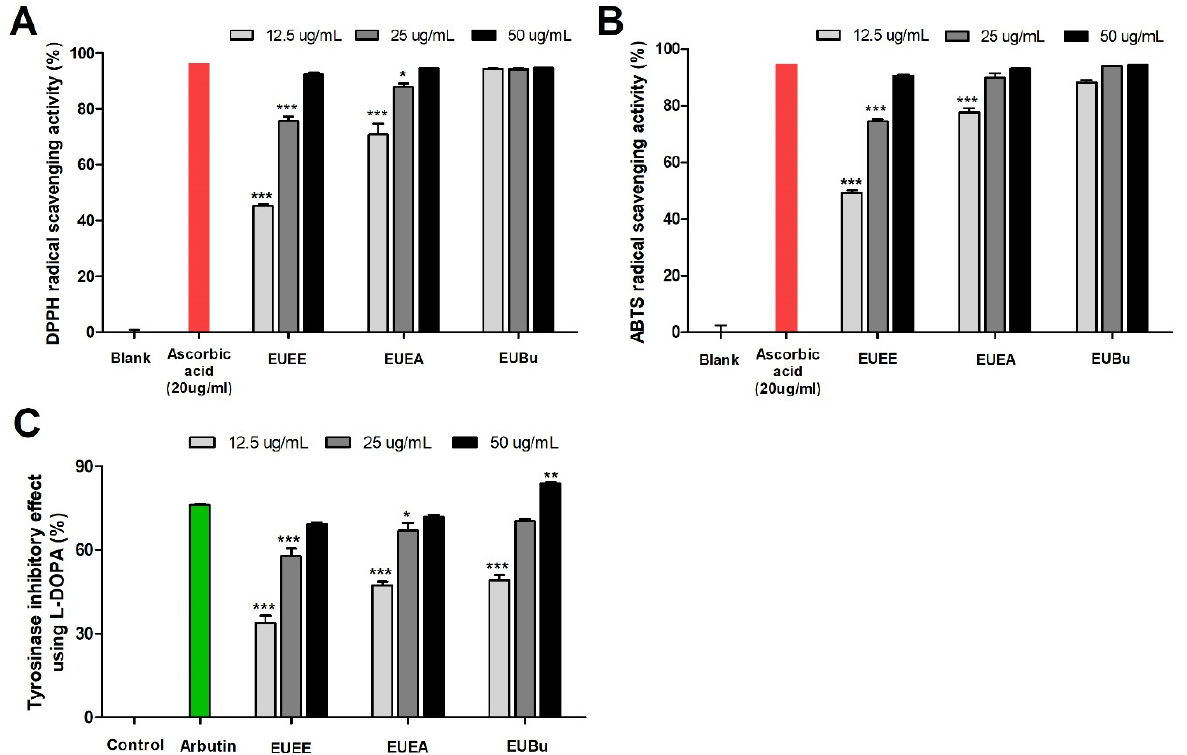
Figure 2. Antioxidant activities and mushroom tyrosinase inhibition activity of EU. Radical scavenging activity of DPPH ( A ) and ABTS ( B ) of EU extract and fractions. Ascorbic acid (20 µ g/mL) was used as a positive control. The tyrosinase inhibitory effect using L-DOPA of EU extract and fractions ( C ). Arbutin (10 mM) was used as a positive control. All graphs show per centages of control, and data are expressed as means ± S.E.M. (n = 3). Statistical significance was set at * p < 0.05, ** p < 0.01 and *** p < 0.001 when compared with the ascorbic acid or arbutin group.